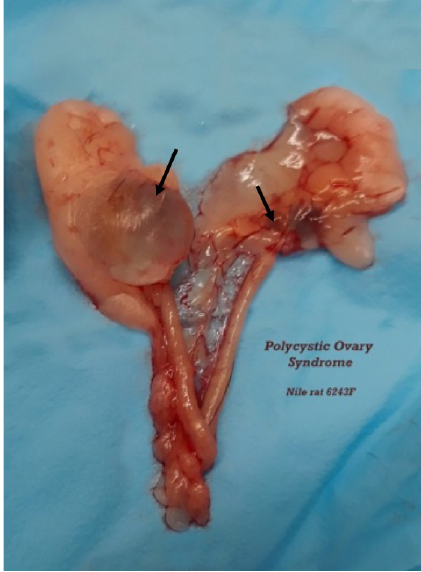
Figure 3. Polycystic ovaries in nulliparous 18-month-old female Nile rat fed rat chow. (RBG = 588 mg/dL and severe hyperlipidemia.)